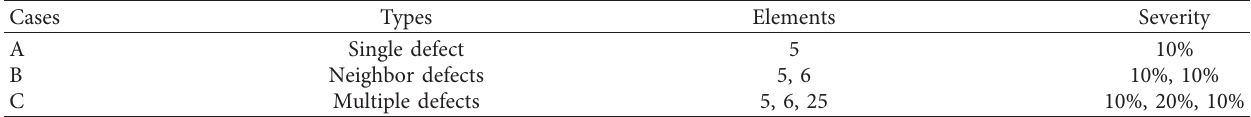
Figure 3: The methodology for defect detection using the standard PSO-FEM approach. Table 1: Defect cases of the cantilever beam.